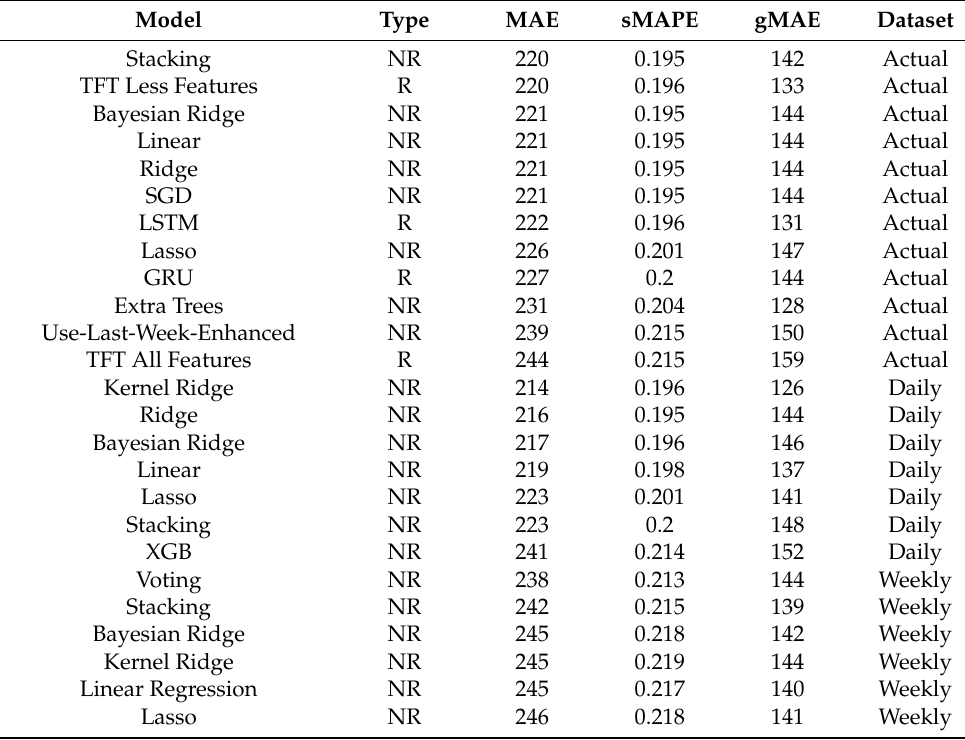
Table 3. Top 25 One-Day Forecast Results. We show the top 25 results for one-day forecasting from all tests, sorted by dataset, then ranked from best to worst. The model, test MAE, sMAPE, gMAPE, and the dataset used to achieve the result are all given. Some best and worst results from each dataset and the baseline are highlighted. The table is sorted by MAE then dataset, and the best results are seen in the Actual and Daily